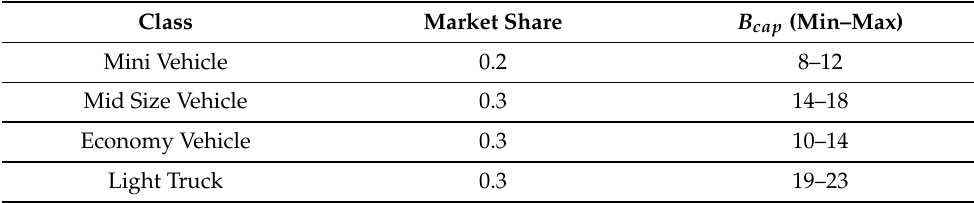
Table 2. Various Classes for